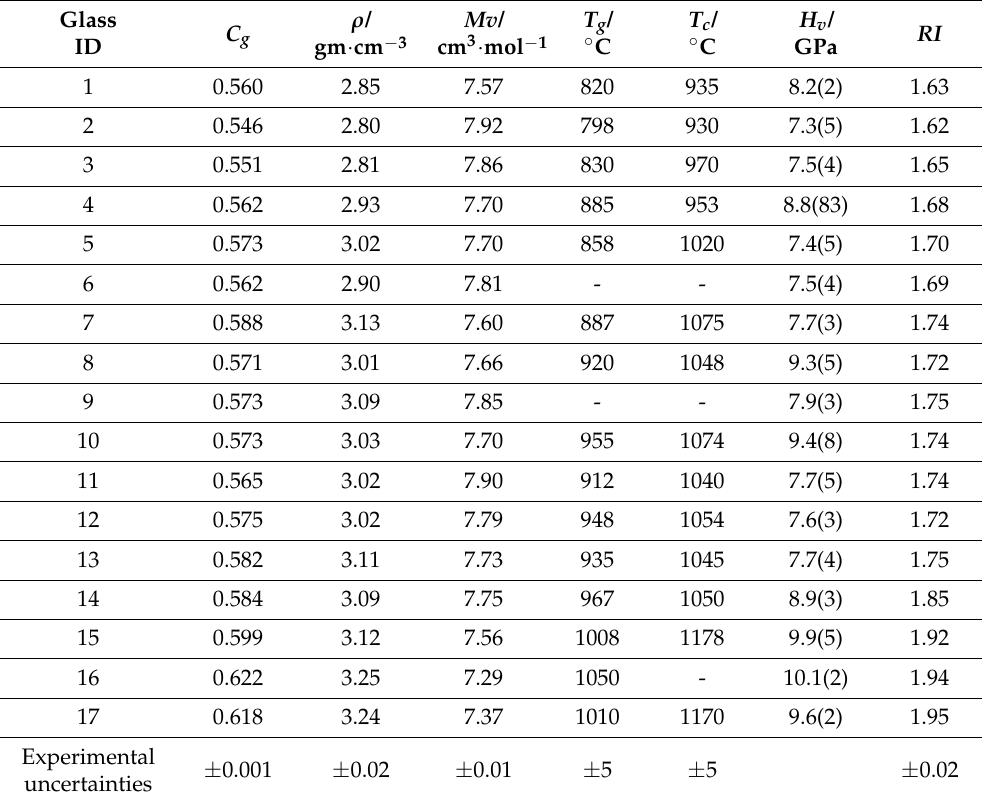
Table 2. Physical properties of Ca–Si–O–N glasses: glass designation, density ( ρ ), molar volume ( Mv ), glass compactness ( C g ), glass transition temperature ( T g ), crystallization temperature ( T c ), Vickers hardness ( H v ), and refractive index ( RI ). Numbers in parentheses are estimated standard deviations.